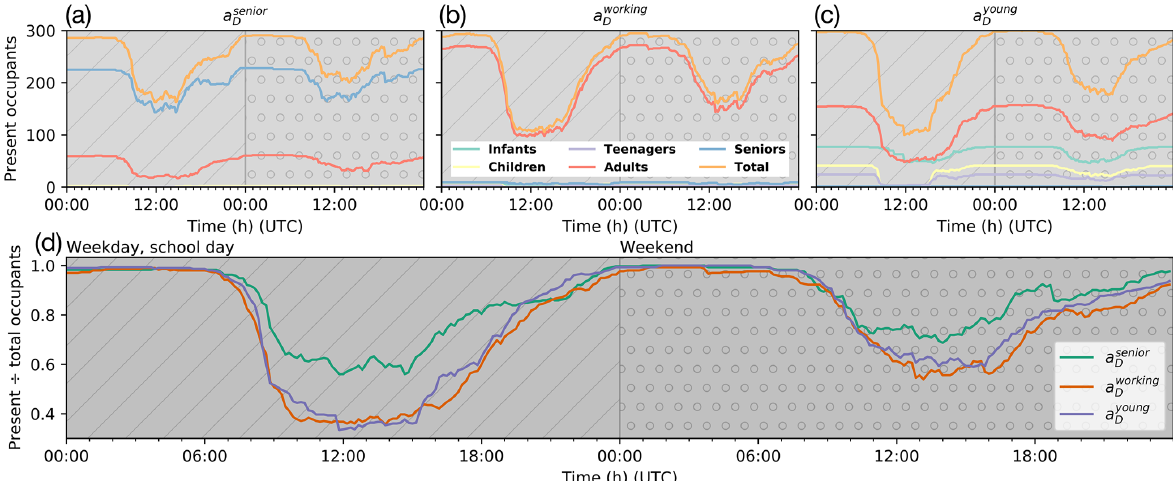
’s by day type (textured background): (a) a senior (number of people per age D D (5 infants, 6 children, 3 teenagers, 274 adults, D